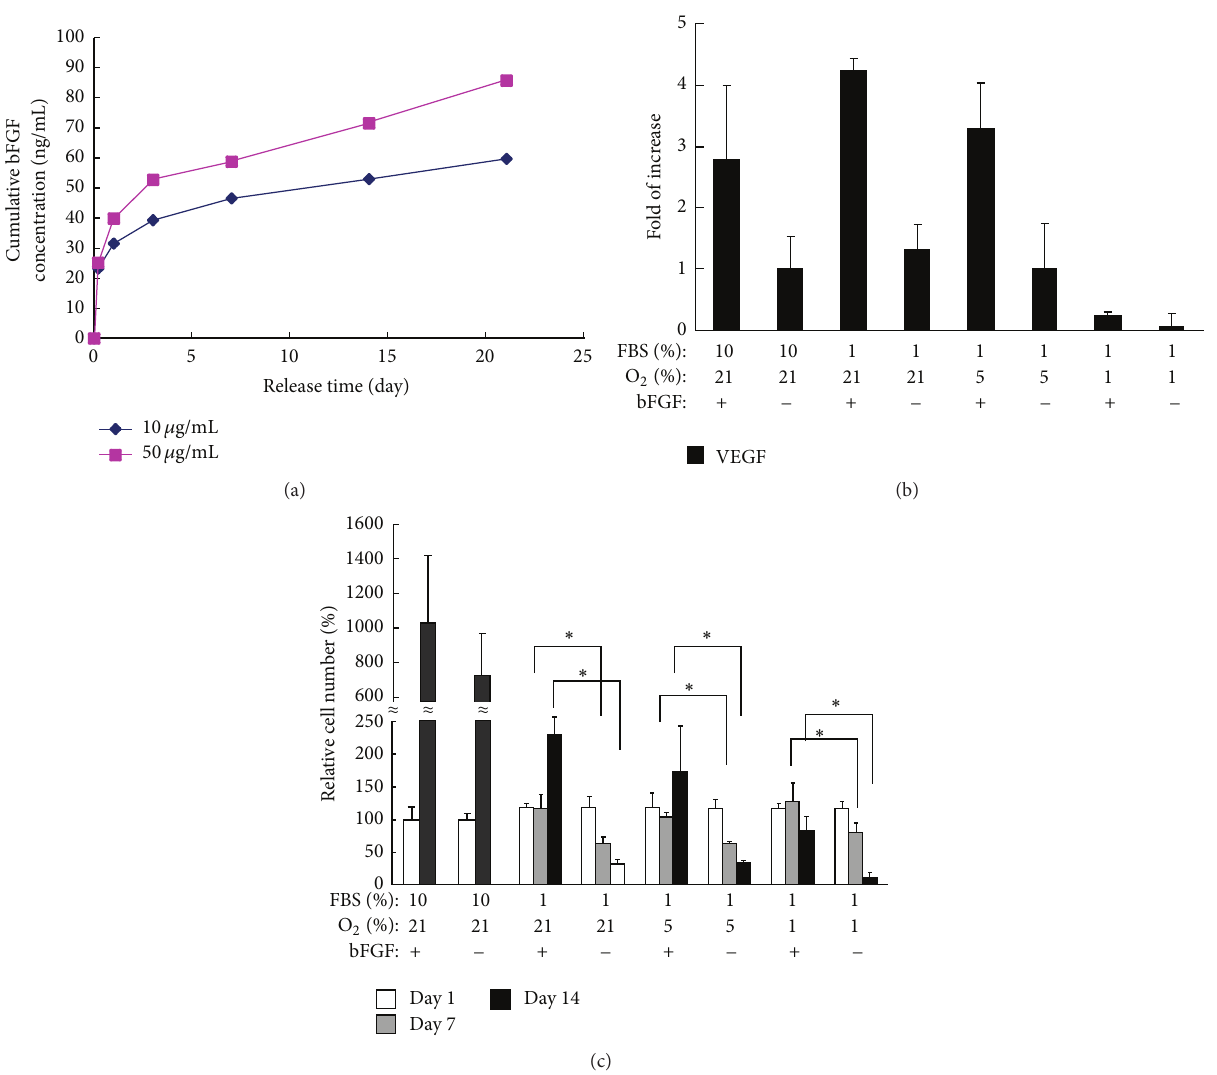
Figure 3: (a) Release kinetics of bFGF loaded in the hydrogels. bFGF loading was 10 and 50 𝜇 g/mL, respectively. The error bars are small. (b) VEGF expression of MSCs in the hydrogels under different culture conditions. Cells were cultured under conditions of 10% FBS and 21% oxygen, 1% FBS and 21% oxygen, 1% FBS and 5% oxygen, and 1% FBS and 1% oxygen, respectively. The expression was normalized by that under 10% FBS with 21% oxygen culture condition. (c) MSC survival in hydrogels cultured under different conditions. Culture conditions: 10% FBS and 21% oxygen, 1% FBS and 21% oxygen, 1% FBS and 5% oxygen, and 1% FBS and 1% oxygen. Double stranded DNA (dsDNA) content was used to quantify live cell number in the hydrogels. The dsDNA content at day 1 (100%) was used for normalization. This figure is adopted from